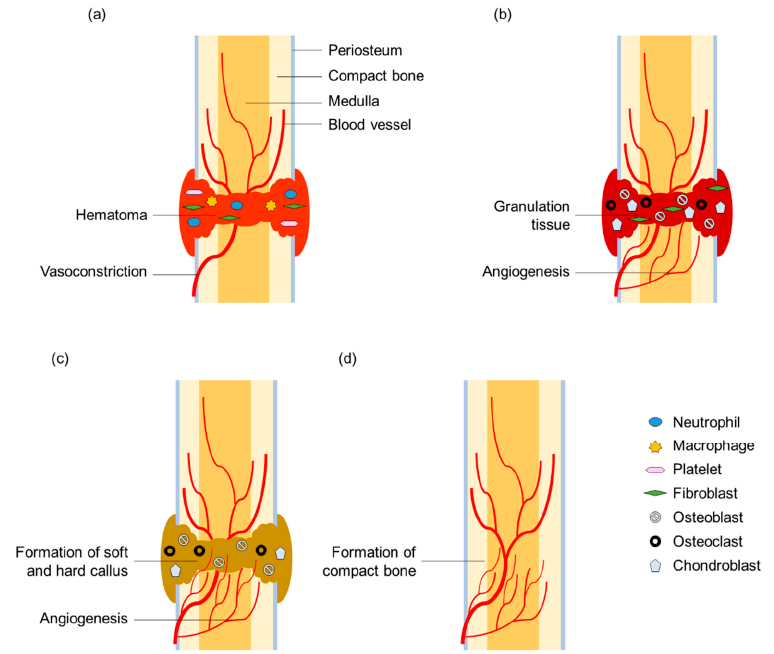
Figure 4. Phases of indirect (secondary) healing after bone fracture in humans. ( a , b ) Reaction involving ( a ) hemostasis, inflammation and ( b ) granulation tissue formation; ( c ) repair involving the formation of cartilage callus and lamellar bone deposition; and ( d ) remodeling (restoration of the original bone contour without scar formation).